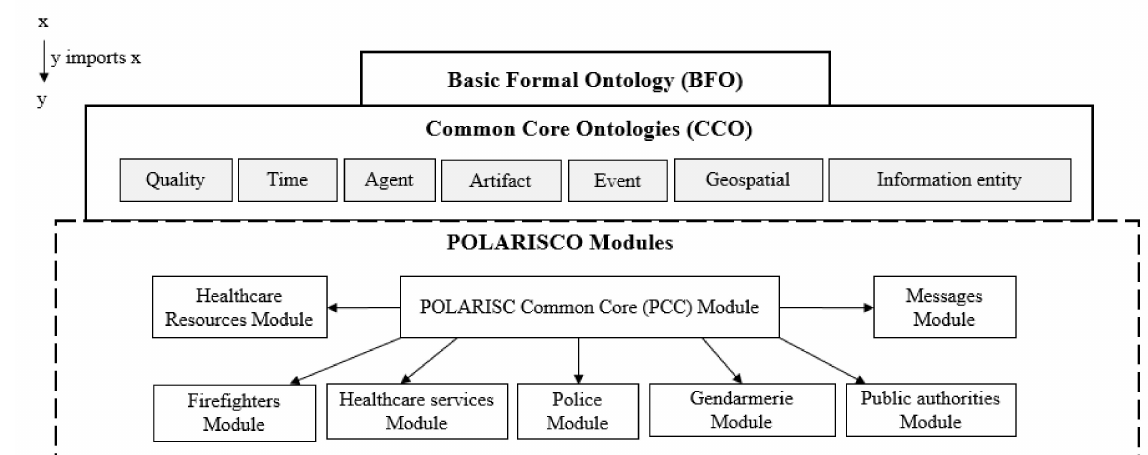
Figure 6. The different modules of POLARISCO.